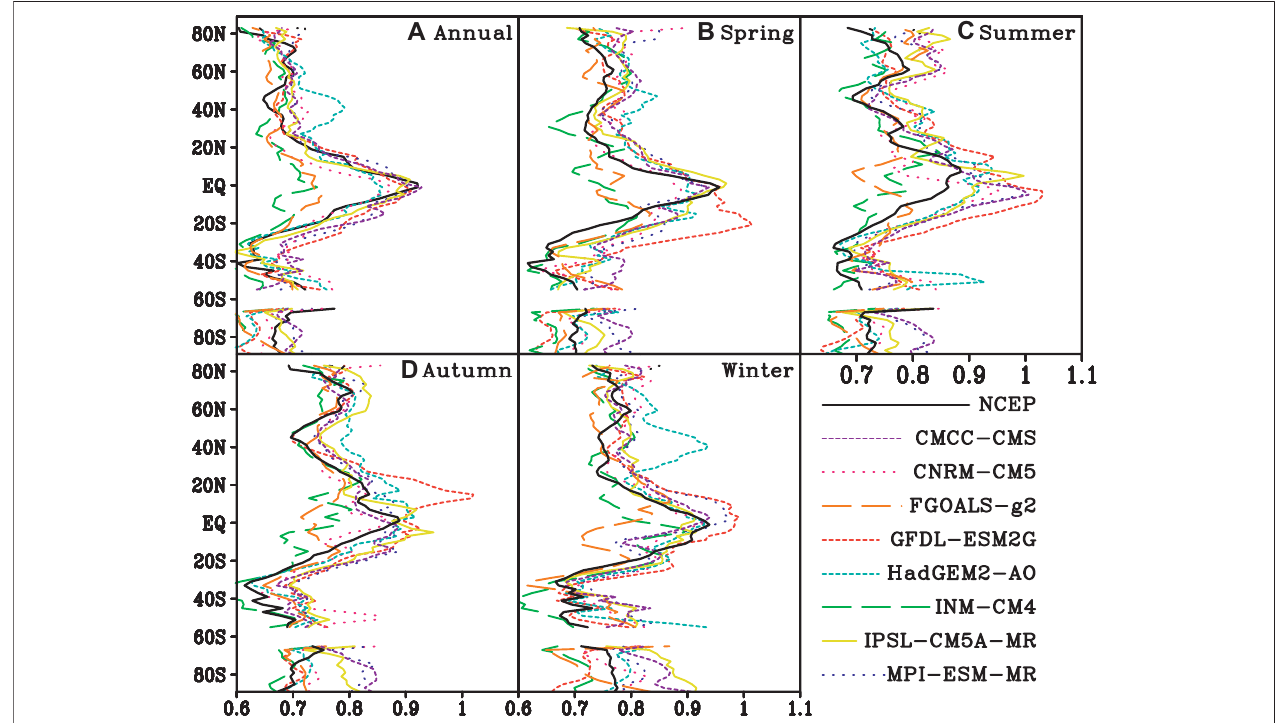
FIGURE 5 | Zonal distribution of scaling exponents of NCEP and the 8 model-simulated SAT throughout (A) whole year; (B) spring; (C) summer; (D) autumn; (E) winter.